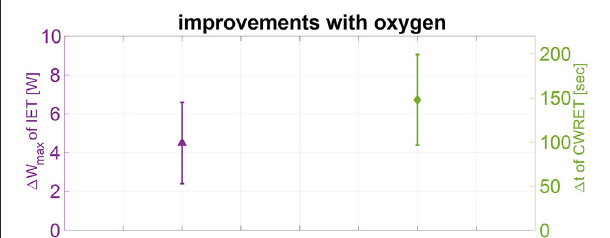
FIGURE 2 | Improvements of the primary outcomes with oxygen. Changes of maximal work-rate [ W max (W)] at the incremental exercise test (left, purple) and mean changes of maximal cycling time [t (s)] of the constant work-rate exercise test (right, green) with oxygen-enriched vs. ambient air are shown as mean ± standard error of mean (SEM). IET, incremental exercise test; CWRET, constant work-rate exercise